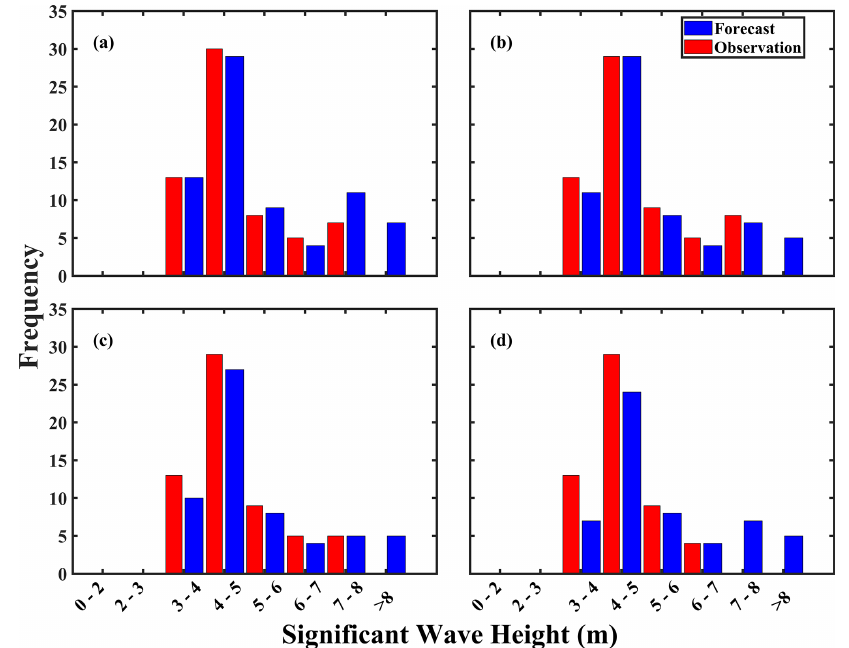
Figure 7. Histograms of Hurricane Dorian observed (red) vs. forecasted (blue) SWH (m) at the (a) 0, (b) 3, (c) 6, and (d) 12h forecast horizons. Results for the 9h forecast are presented in Fig.